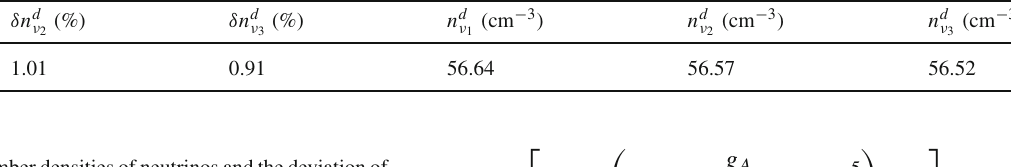
Table 2 The present number densities of neutrinos and the deviation of those from the instantaneous decoupling limit in the mass basis including neutrino spectral distortions in the SM